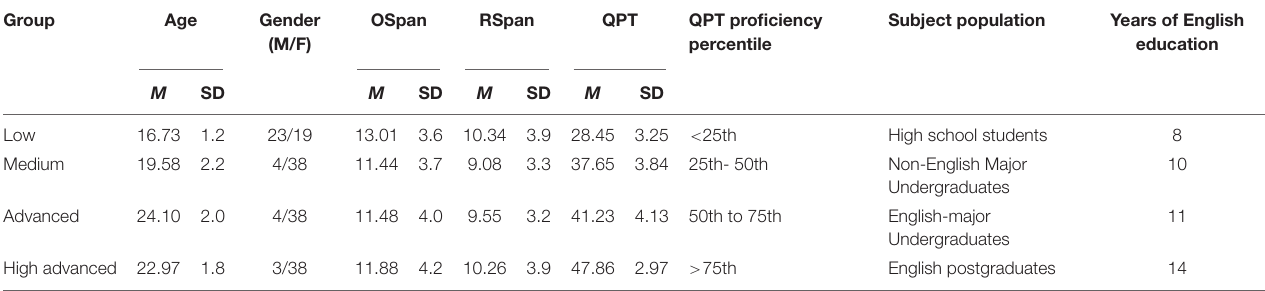
TABLE 1 | Demographic information for the four participant groups. Group Age Gender OSpan RSpan (M/F)